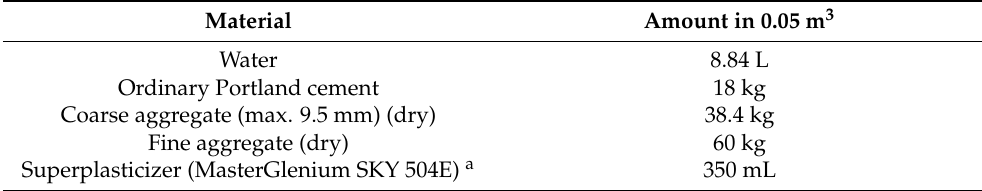
Figure 3. ( a ) Close ‐ up view of the artificially created defects inside the wooden mold before pouring the concrete, ( b ) when curing the sample inside the water tank, and ( c ) the hardened concrete slab. Note: the numbers in ( a ) are used to represent the defect order and do not represent their depth. Table 1. The mix proportions of the concrete mixture.